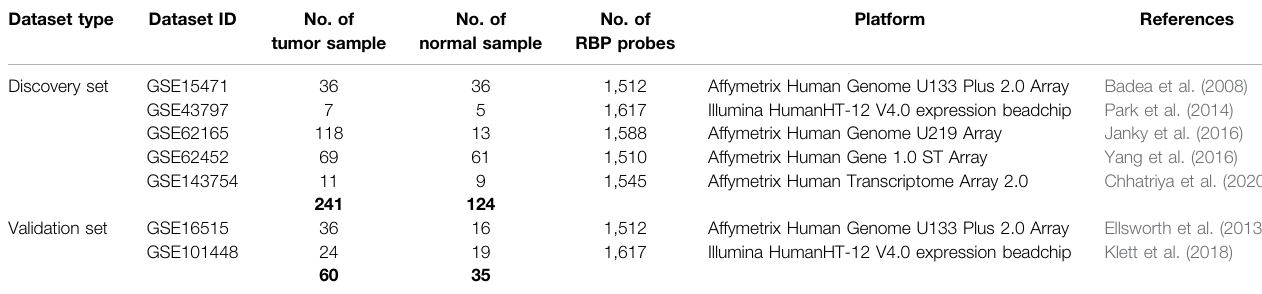
TABLE 1 | Mircoarray dataset information from GEO used for meta-analysis. The top fi ve datasets are used for meta-analysis of the discovery cohort, and last two datasets are used for meta-analysis of the validation cohort. Dataset